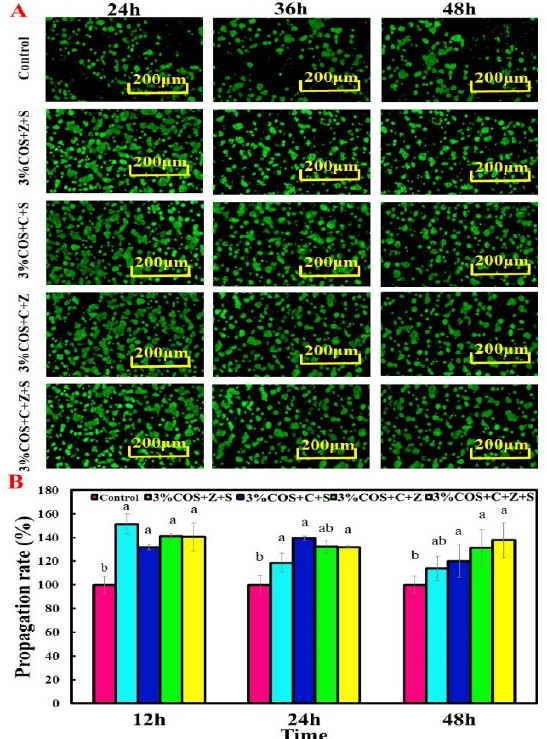
Figure 4. In vitro cytotoxicity test of nIon 2+ − COS/SA gel film extracts. ( A ) HaCaT AO/EB fluores- cence staining for 24 h, 36 h and 48 h (magnification: × 5). Cells fluoresce green after acridine orange (AO) crosses the intact cell membrane and embeds in nuclear DNA. Ethidium bromide (EB) penetrates damaged membranes, interacts with DNA and fluoresces orange-red. ( B ) Cell viability was assayed by CCK-8 assay. HaCaT cells were maintained for 12 h, 24 h and 48 h under the conditions described. Note: Same superscript letters indicate no significant difference ( p > 0.05), different superscript letters indicate significant difference ( p <